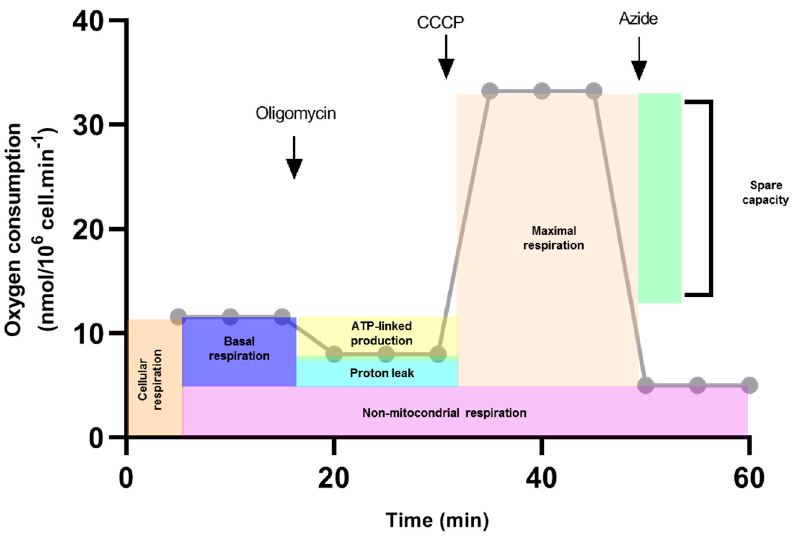
Figure 1. Calculations of mitochondrial function (Theorical example). Oxygen consumption rate was measured in response to sequential injections of oligomycin, CCCP and sodium azide (arrows). First, cellular respiration was evaluated. Oligomycin was added and oxygen consumption was traced. This record is used to calculate ATP-linked production and proton leak. The CCCP proton ionophore collapses the inner membrane gradient, which drives the electron transport chain to function at its maximum rate (Maximal respiration). Non-mitochondrial respiration was calculated when sodium azide was added. Basal respiration was estimated by subtracting the non-mitochondrial respiration of cellular respiration. Spare capacity was determined by subtracting basal respiration from maximal respiration.